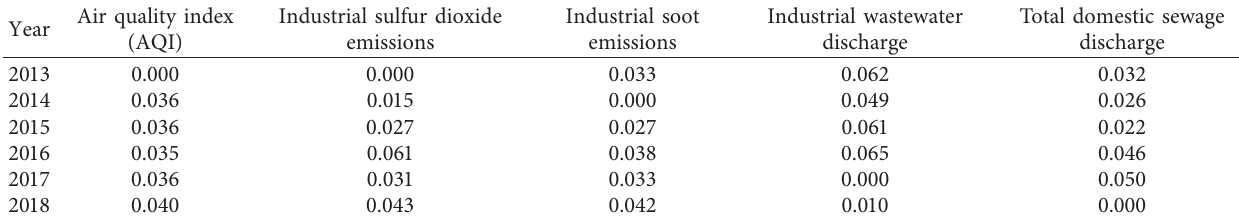
Table 6: Environmental pressure scores of Liupanshui in